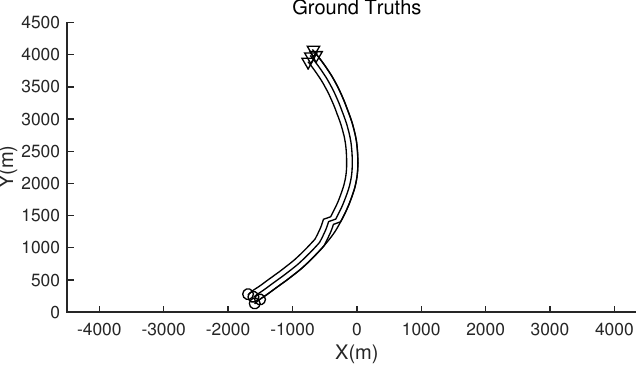
Figure 19. The track of the single group targets.